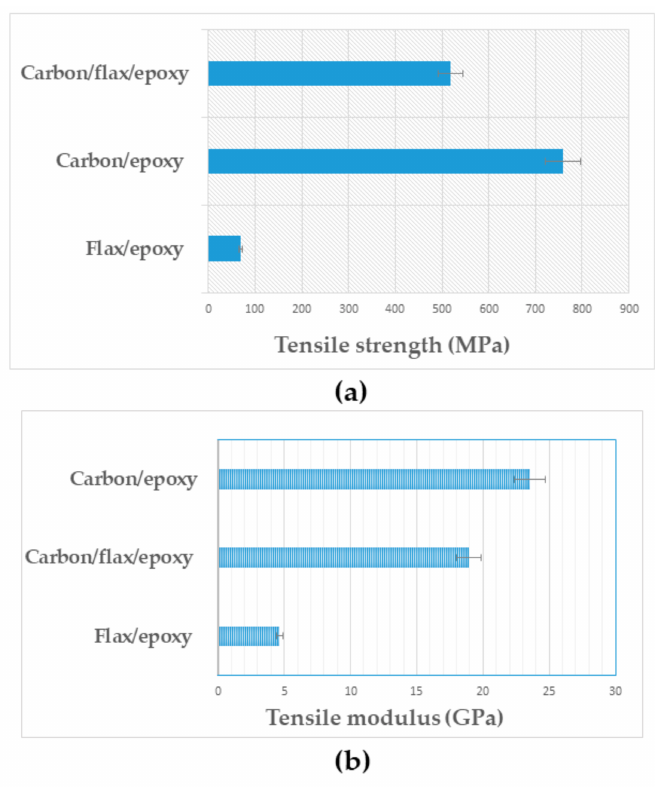
Figure 2. Comparative results of tensile strength ( a ) and modulus ( b ) for di ff erent